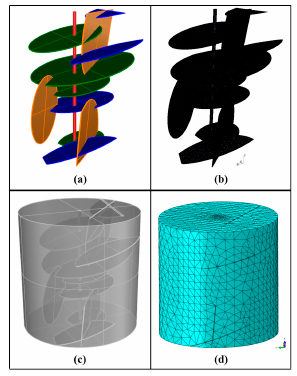
Figure 7. Selected grouting simulation area.